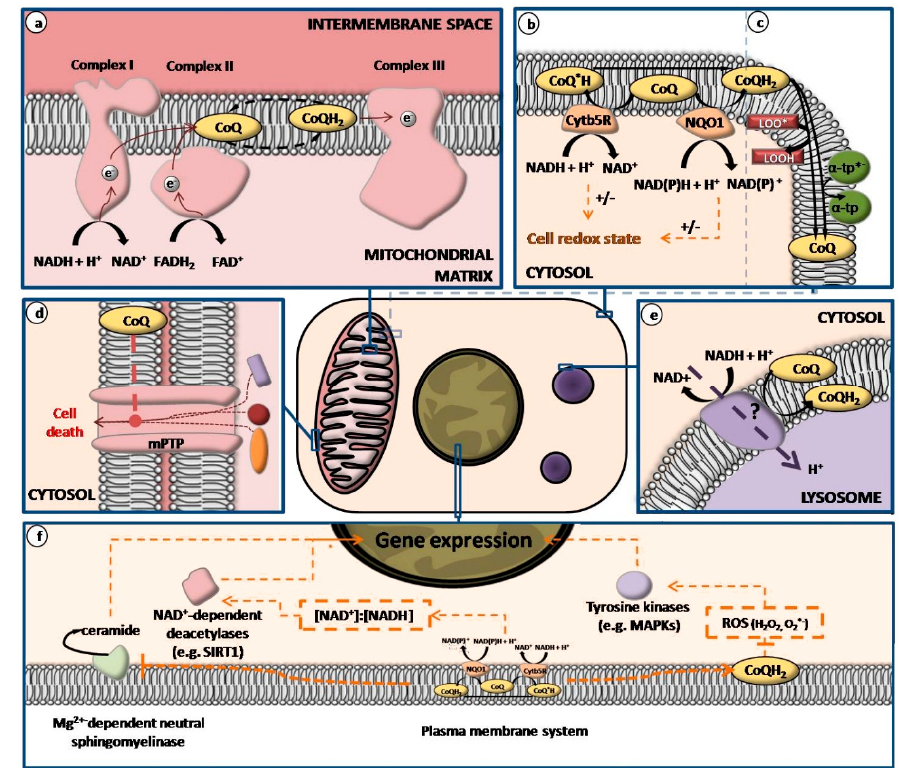
Figure 2. Different activities exerted by coenzyme Q in cells: ( a ) coenzyme Q has a central role in mitochondrial electron transport chain; ( b ) plasma membrane redox system components; ( c ) antioxidant roles of coenzyme Q (this can occurs in all membranes where ubiquinol is present); ( d ) coenzyme Q prevent permeability transition pore opening; ( e ) coenzyme Q participates in lysosomal pH maintenance;